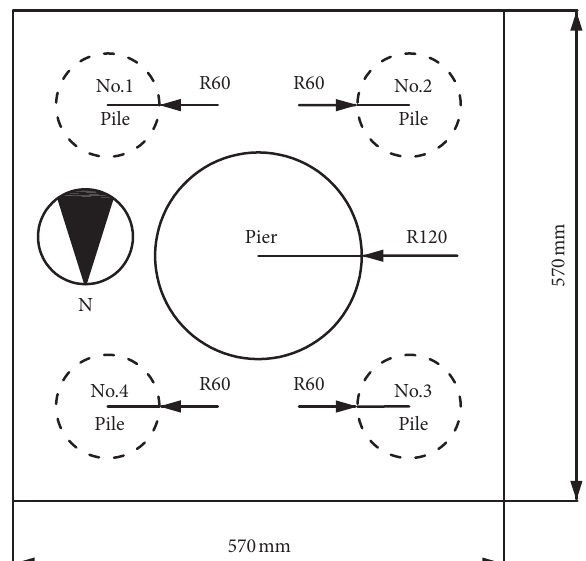
Figure 8: Layout of the pile.